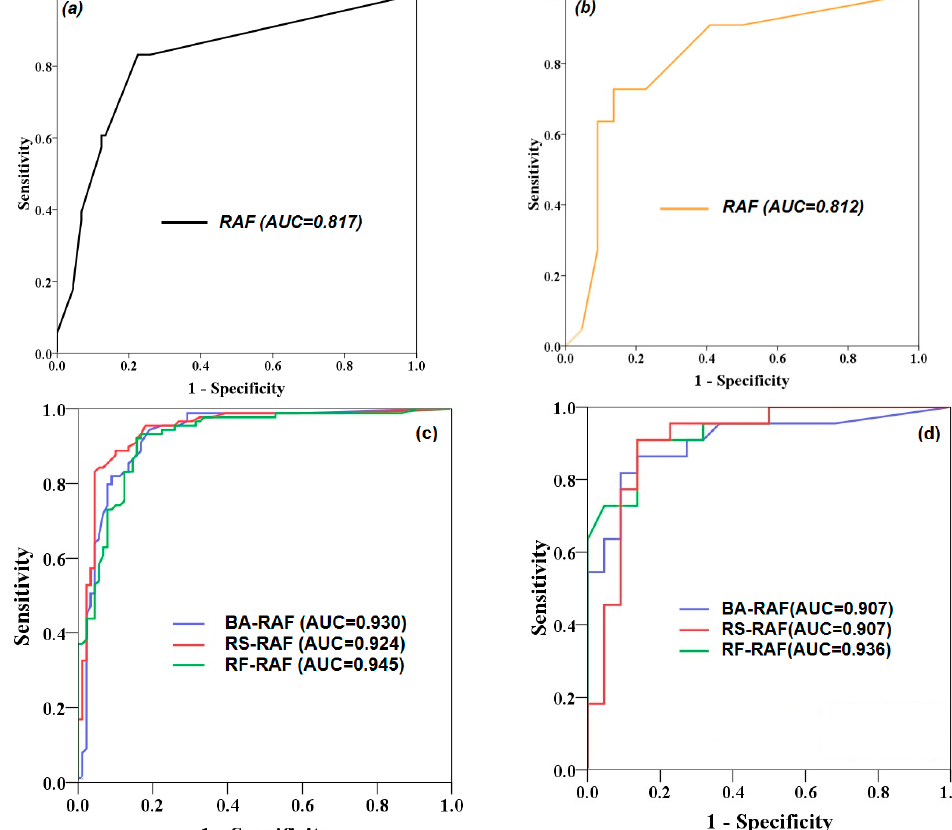
Figure 7. Receiver operating characteristic (ROC) curves and AUC values of the machine learning models. ( a ) RAF model, training dataset. ( b ) RAF model, validation dataset. ( c ) Ensemble models, training dataset. ( d ) Ensemble models, validation dataset.